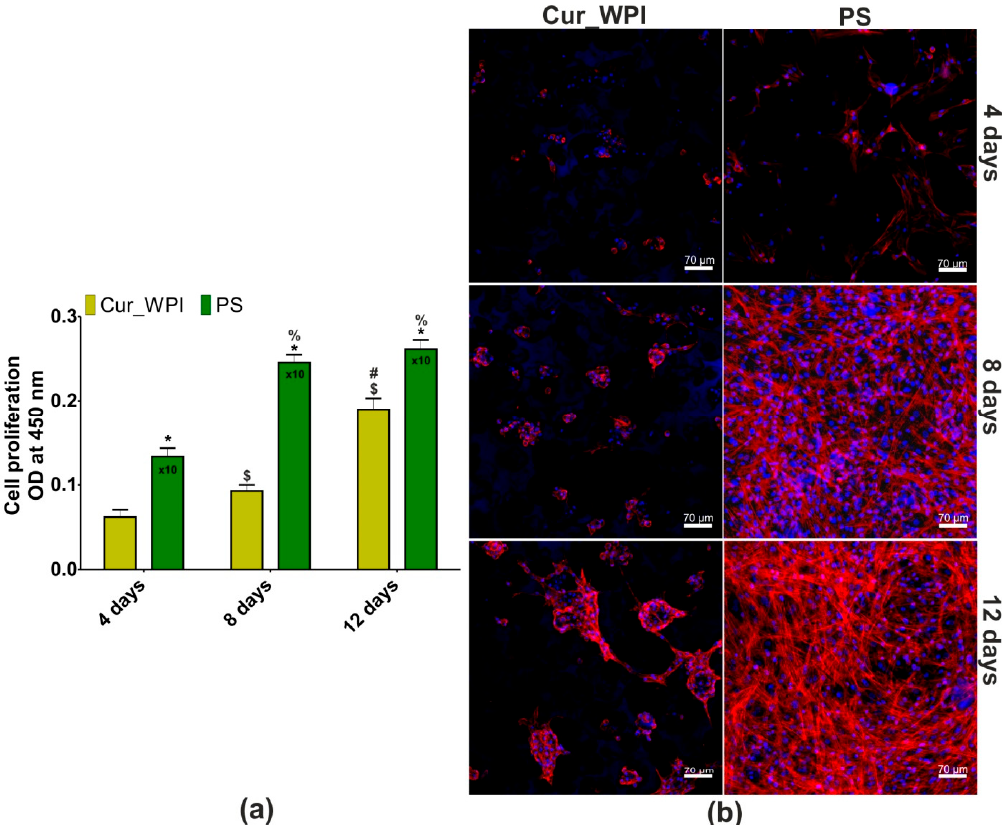
Figure 6. Proliferation of chondrocytes after 4, 8, and 12 days of culture ( a ). The results were obtained via a WST-8 assay (* significantly different results between Cur_WPI biomaterial and polystyrene (PS) at the same time of incubation; $ significantly different results compared with Cur_WPI biomaterial at day 4; # significantly different results compared with Cur_WPI biomaterial at day 8; % significantly different results compared with PS at day 4; one-way ANOVA test followed by Tukey’s multiple comparison, p < 0.05). Confocal microscope images showing morphology of chondrocytes cultured on Cur_WPI biomaterial and polystyrene (PS, control) after 4-, 8-, and 12-day incubation ( b ). Nuclei emitted blue fluorescence (visible blue fluorescence in the structure of biomaterial was emitted by WPI), while F-actin filaments gave red fluorescence; magnification 200×, scale bar equals 70 μ m.